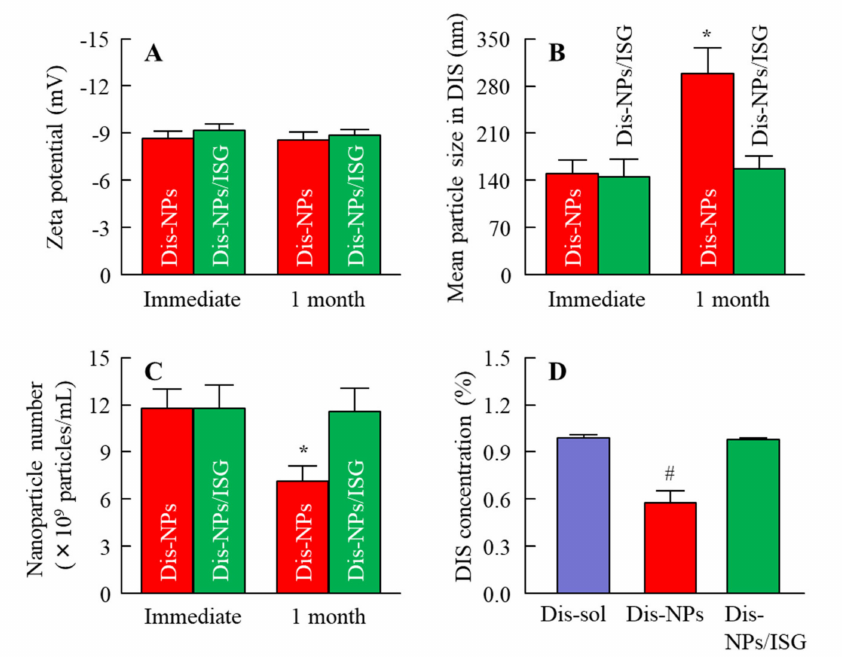
Figure 3. Changes in the zeta potential of, and the nanoparticles and dispersibility in, the ophthalmic DIS formulations 1 month after bead mill treatment. A–D: Zeta potential ( A ), mean particle size ( B ), number of particles ( C ), and dispersibility ( D ) of DIS in the ophthalmic DIS formulations. The composition of the Dis-sol, the Dis-NPs, and the Dis-NPs / ISG is shown in Table 1. n = 8. * p < 0.05 vs. the immediate group for each category. # p < 0.05 vs. the Dis-sol. The zeta potential of the Dis-NPs and the Dis-NPs / ISG was similar. Aggregation and precipitation in the Dis-NPs was observed 1 month after preparation, since the particle size was increased, and the number of nanoparticles was decreased. In contrast to the results in Dis-NPs, the Dis-NPs / ISG remained stable 1 month after